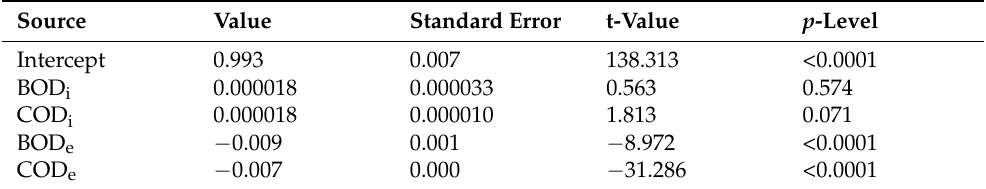
Table 5. Regression coefficients analysis for the XLSTAT model.